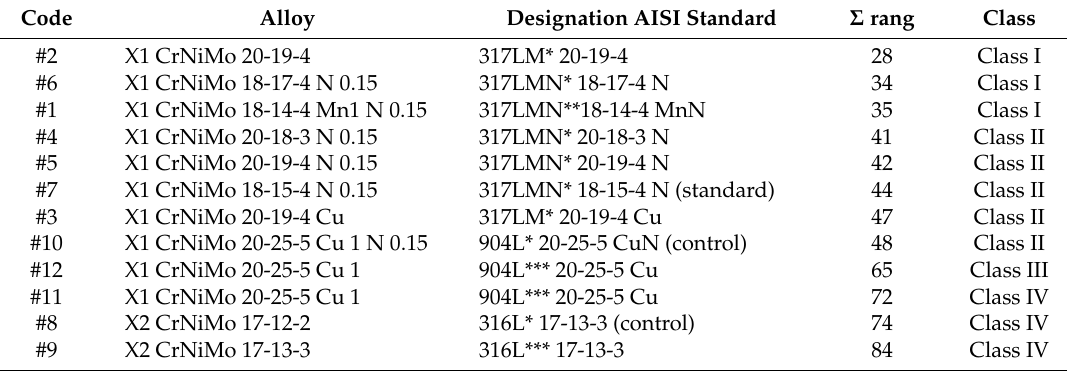
Table 7. Kendal classification of steels in generalized corrosion and crevice